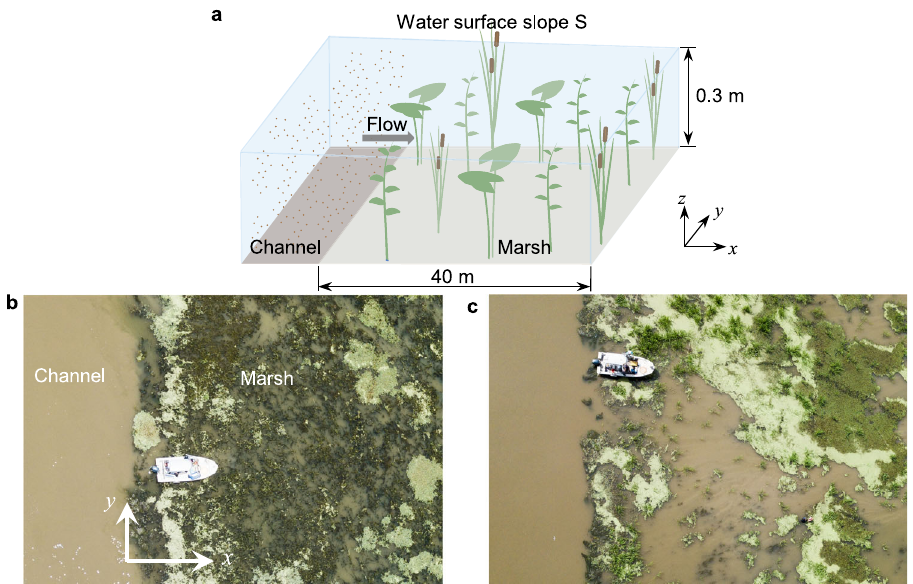
Fig. 1 | Modeled scenario including a channel and a marsh with emergent vegetation. a Schematicofmodeled scenario withtypicalscales. b Photo of a fi eld siteinCubitsGapsub-delta,MRD,takeninJune2019,correspondingtothehighest